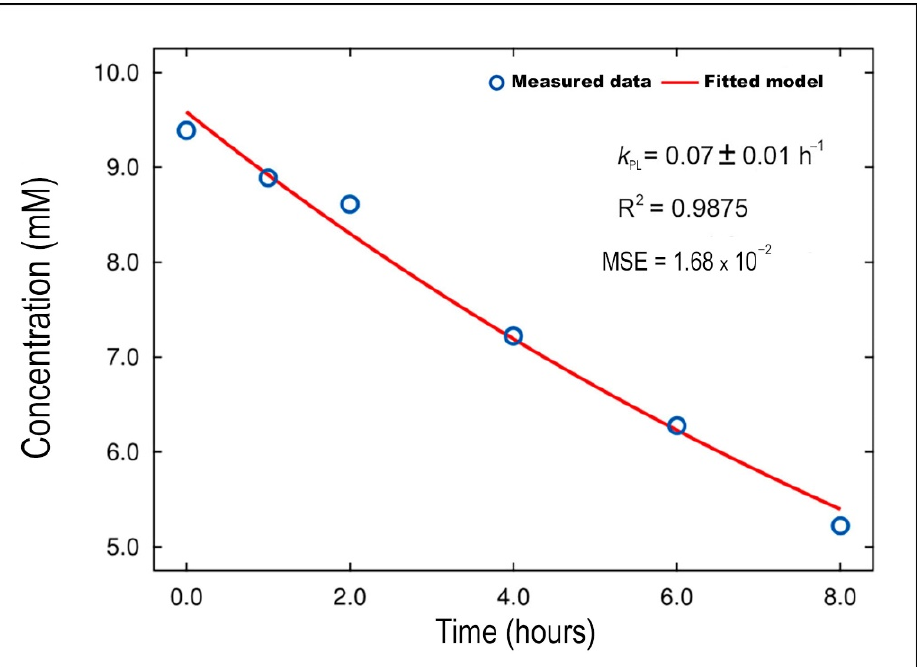
Figure 11. Fit of the experimental data C ( t ) of the ammonia removal photolysis process to the first order monoexponential rate equation tending to zero (pH = 11.0, P = 25 W, Q = 1000 L/h, temperature = 20 ± 1 °C.